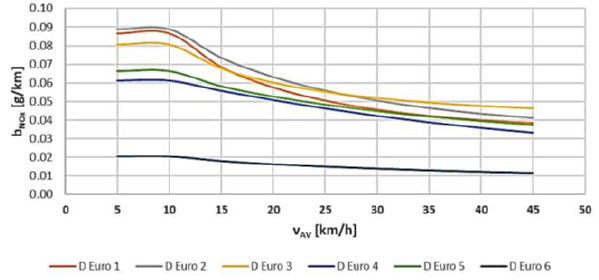
Fig. 16. NO x emission from diesel oil PCs for vehicle segments depending on average speed